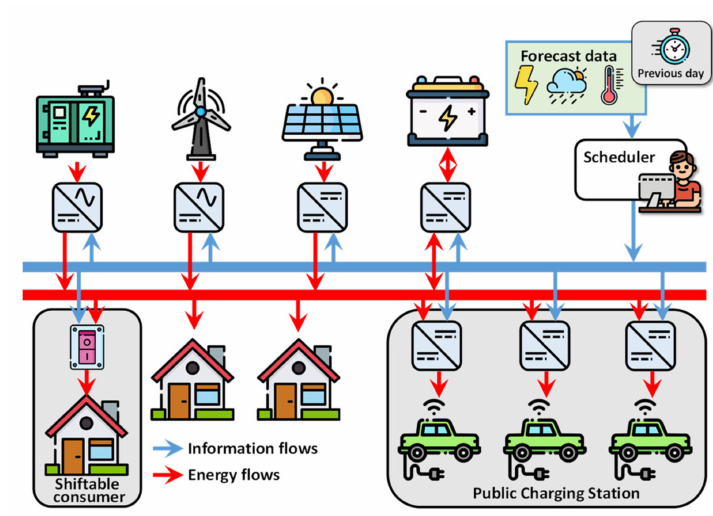
Figure 2. Layout of the NG under